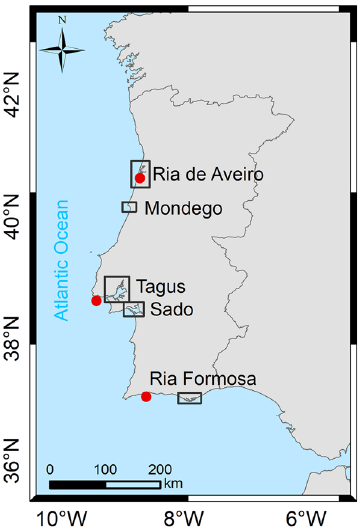
Figure 1. Map of Portugal depicting the location of the estuarine systems under study. The red dots show the location of tidal gauges whose elevation data was used to determine extreme levels (from north–south: Aveiro, Cascais and Lagos). This map was created with Esri ArcGIS 10.8 software (https:// www. esri. com/ en- us/ home).